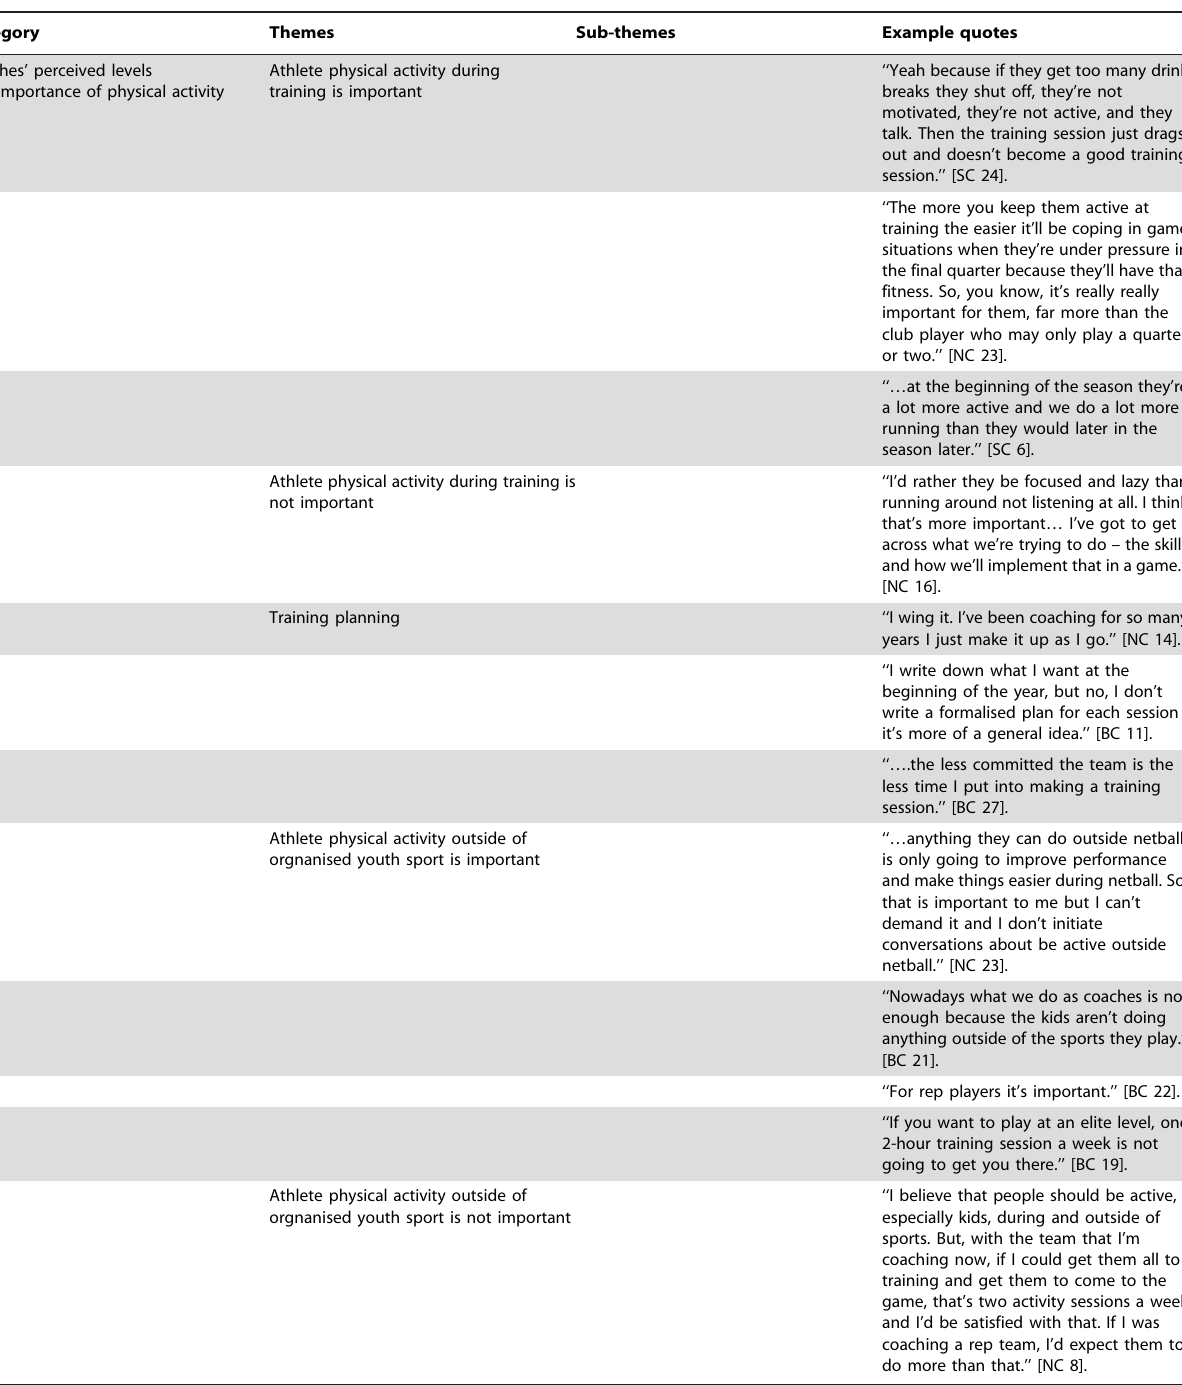
Table 5. Coaches’ perceived levels and importance of physical activity: summary of categories, themes, sub-themes, and example